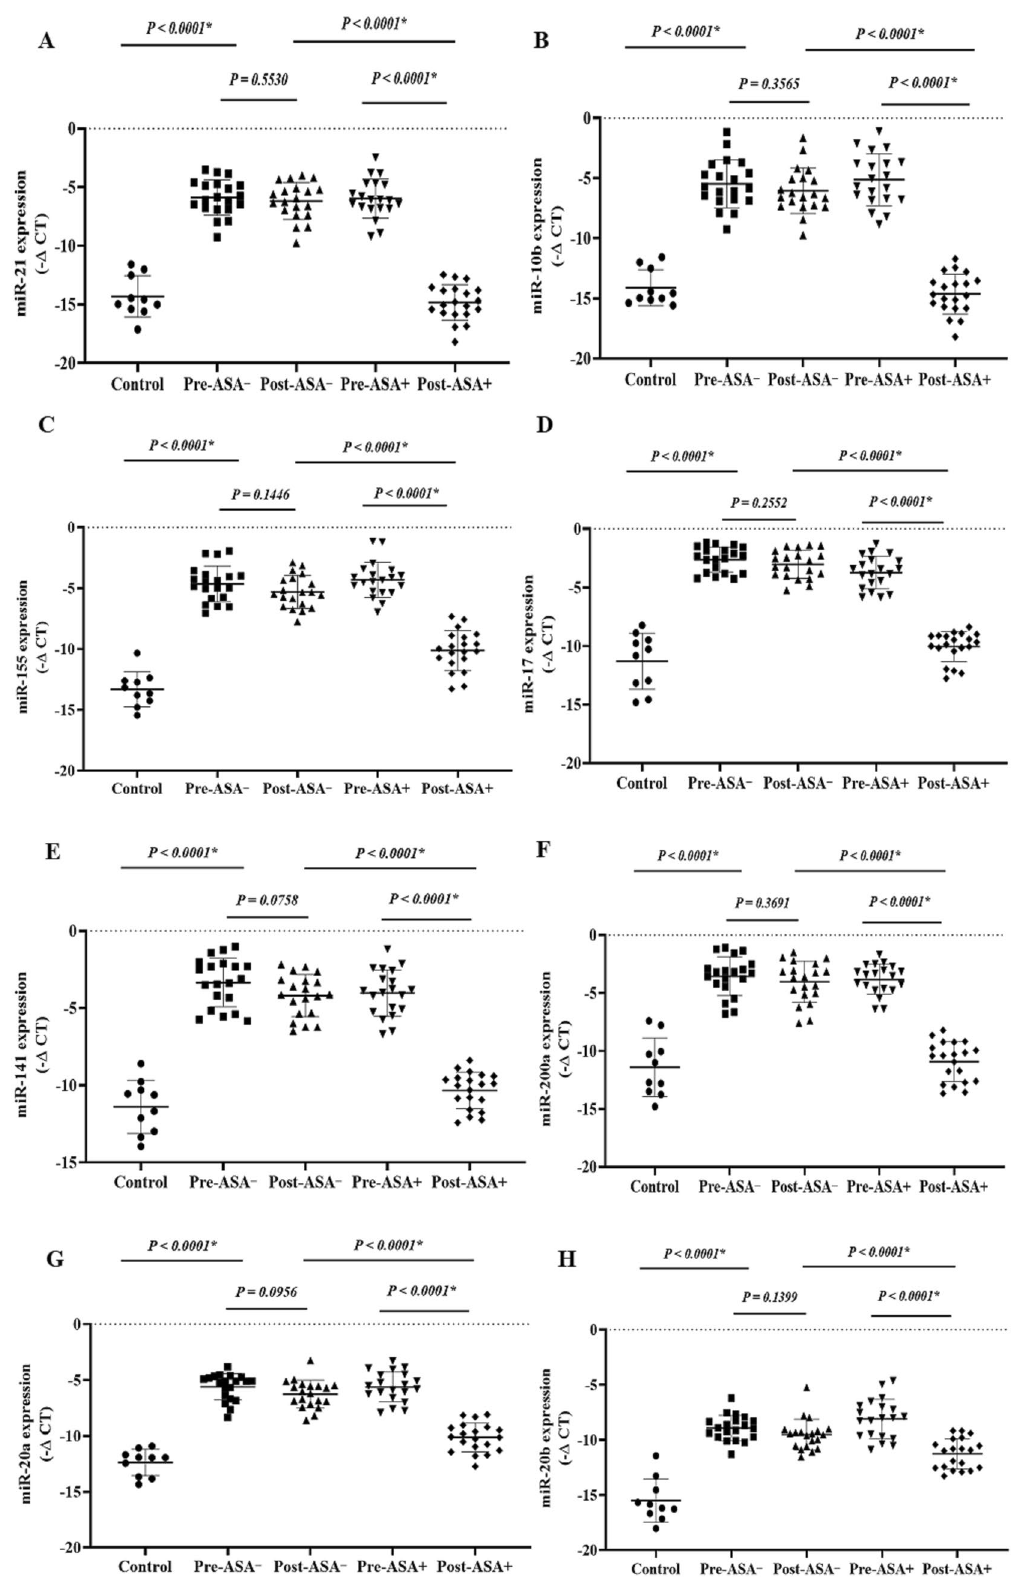
Figure 7 . The relative expression of the candidate miRs in the breast cancer patients. The relative expression levels of the miRs were normalized by a reference RNA. The oncomiRs included: ( A ) miR-21, ( B ) miR-10b, ( C ) miR-155, ( D ) miR-17, ( E ) miR-141, ( F ) miR-200a, ( G ) miR-20a, and ( H ) miR-20b. Tumor suppressor miRs included: ( I ) miR-145, ( J ) miR-224, ( K ) miR-125a, and ( L ) miR-205. ASA−: Non-aspirin group, ASA+: Aspirin group. The expression levels of the miRs were calculated using the –ΔCT